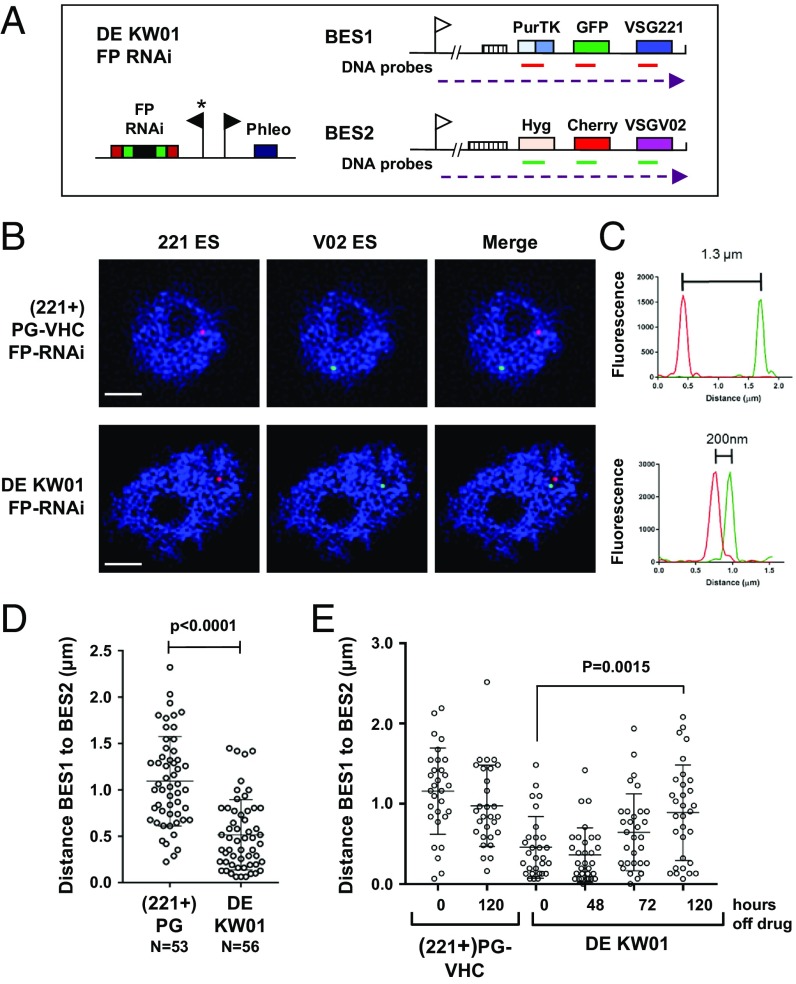
ESs are located in closer proximity to each when there is selection for simultaneous activation in a double-expresser strain compared with the single-expresser parental strain. (A) The schematic shows the DE KW01 FP-RNAi cell line, which contains the FP-RNAi construct, which allows transient knock-down of the fluorescent proteins eGFP and mCherry. Promoters are indicated with flags, and the tetracycline-inducible promoter indicated with an asterisk. Relevant genes are indicated with colored boxes and unstable transcription of BES1 and BES2 with dashed arrows. The location of the DNA-FISH probes for BES1 are indicated with red lines and those for BES2 with green lines. (B) Representative superresolution microscopy images of DNA FISH performed in the single-expresser (221+)PG-VHC FP-RNAi and double-expresser DE KW01 FP-RNAi lines after probing for BES1 (red) and BES2 (green). DNA is stained with DAPI (blue). (Scale bars, 1 µm.) (C) Quantitation of the distance between BES1 and BES2 in the images shown in B. Fluorescence intensity is shown in arbitrary units. (D) Distance between BES1 and BES2 in the single-expresser (221+)PG-VHC cell line compared with the double-expresser DE KW01 line as determined by using DNA FISH and superresolution microscopy. Data were collected from at least 3 biological replicates, with the average value shown with a bar ± SD and the significance of colocalization indicated with the P value. Total number (N) of cells analyzed is indicated below. (E) Reversibility of BES colocalization shown through quantitation of the distance between BES1 and BES2. DNA FISH was performed in the (221+)PG-VHC and DE KW01 cell lines in the presence or after the removal of drug selection for the time indicated in hours. Data were collected at 0 h, 24 h, 48 h, 72 h, 96 h, and 120 h for both the (221+)PG-VHC and DE KW01 cell lines; however, only some relevant time points are shown. Data shown were obtained from 3 biological replicates by using immunofluorescence microscopy, with at least 29 cells quantitated per time point. The average value is indicated ± SD with the significance of reversibility of colocalization indicated with a P value.